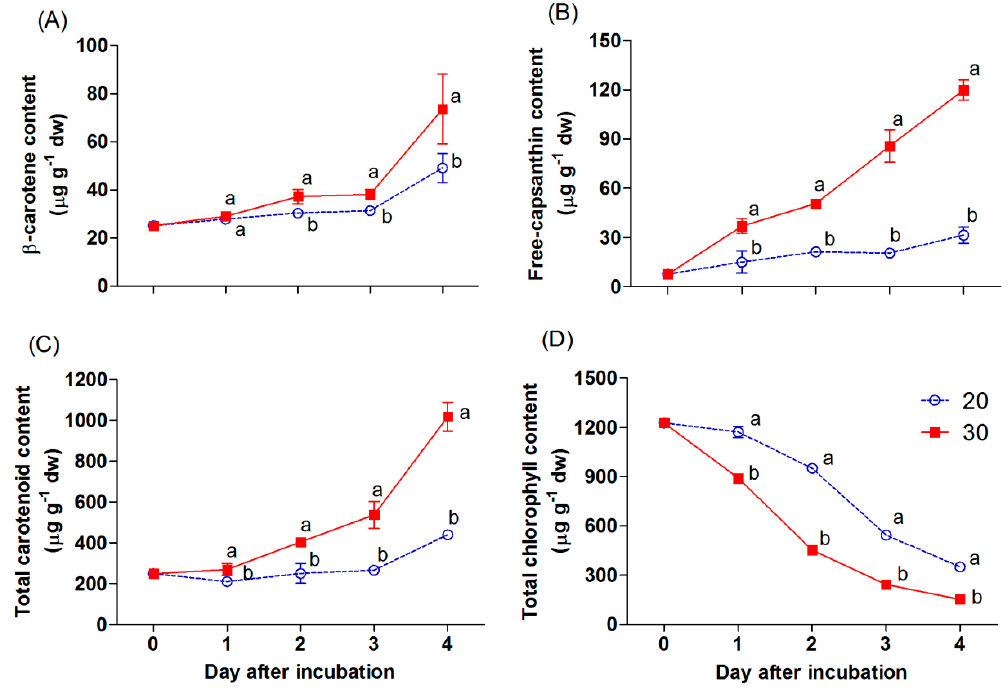
Figure 4. E ff ect of incubation temperatures at 20 and 30 ◦ C on β -carotene ( A ), free-capsanthin ( B ), total carotenoid content ( C ), and total chlorophyll content ( D ) of “Takanotsume” chili for 4 days. Values are means ± SD ( n = 3). Di ff erent letters indicate a significant di ff erence between temperatures on the same day of incubation ( p ≤ 0.05).